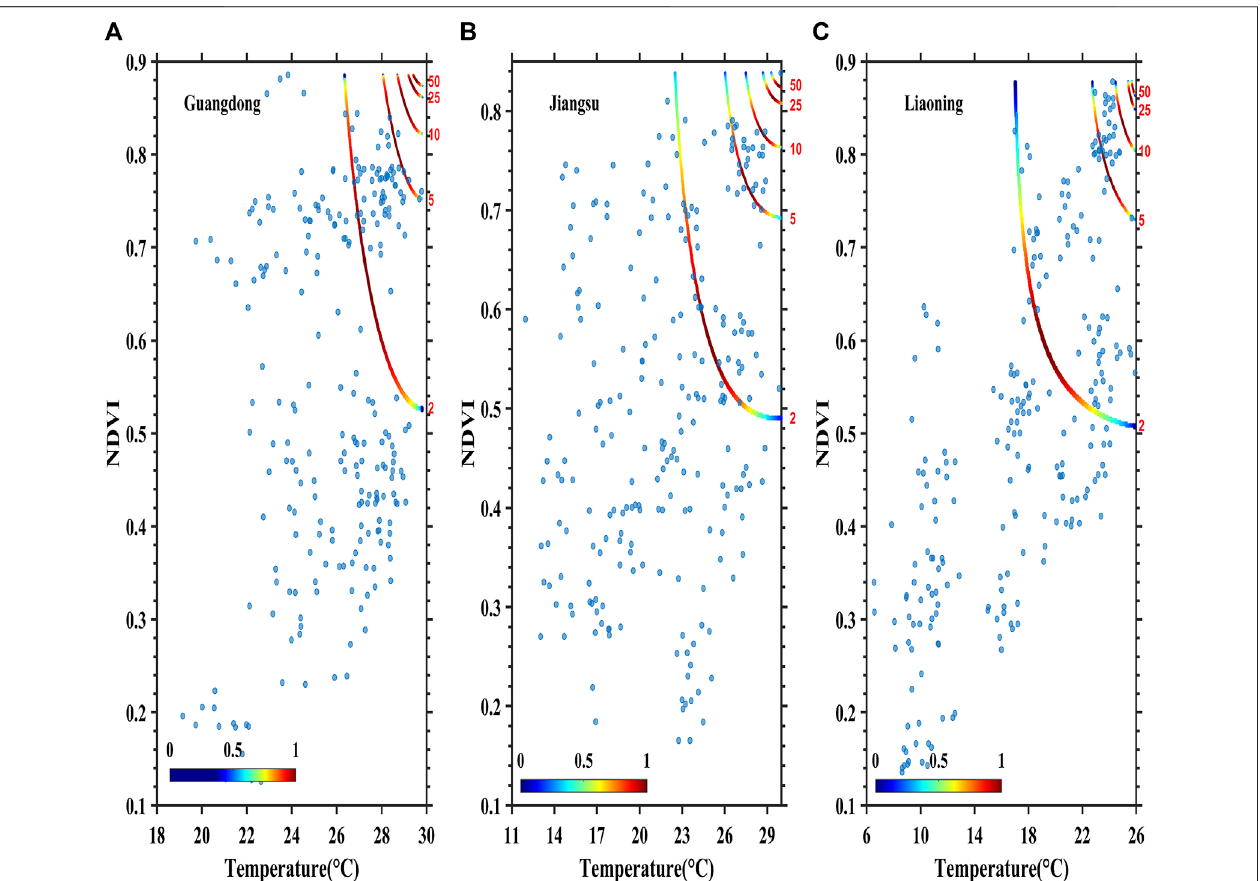
FIGURE 5 | Joint copula return periods of mean temperature-normalized difference vegetation index (NDVI) in (A) Guangdong, (B) Jiangsu, and (C) Liaoning.